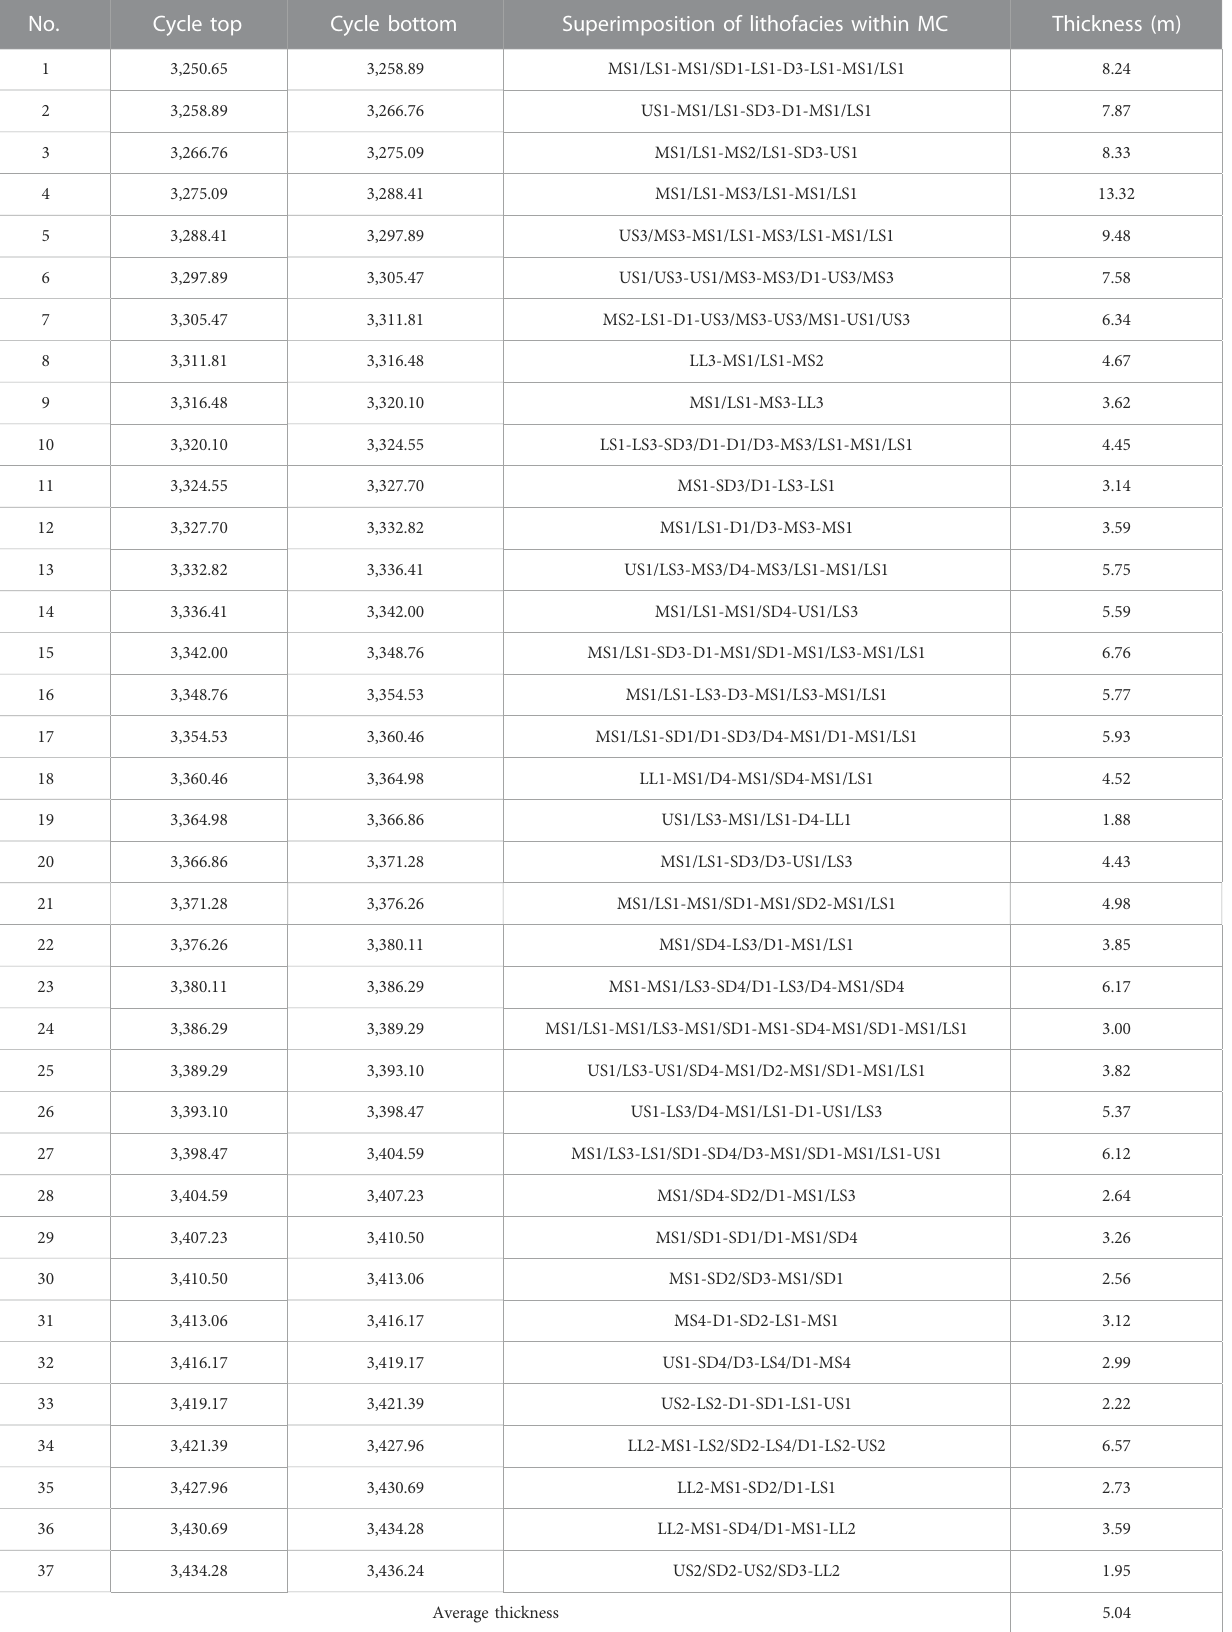
TABLE 1 Superimposition of lithofacies within MCs and their thicknesses.